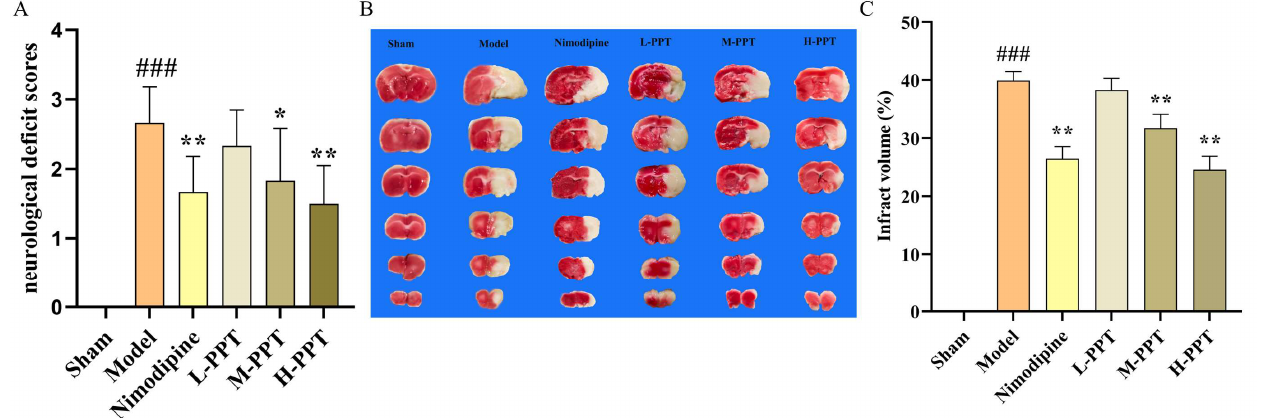
Figure 2. Effect of PPT improves the ischemia-reperfusion injury in rats. The results of neurological deficit score in different groups ( A ) ( n = 6); the TTC staining and infraction rate of brain tissue in different dose groups ( B , C ) ( n = 3). ### p < 0.001 vs. control. * p < 0.05, ** p < 0.01 vs. model group.